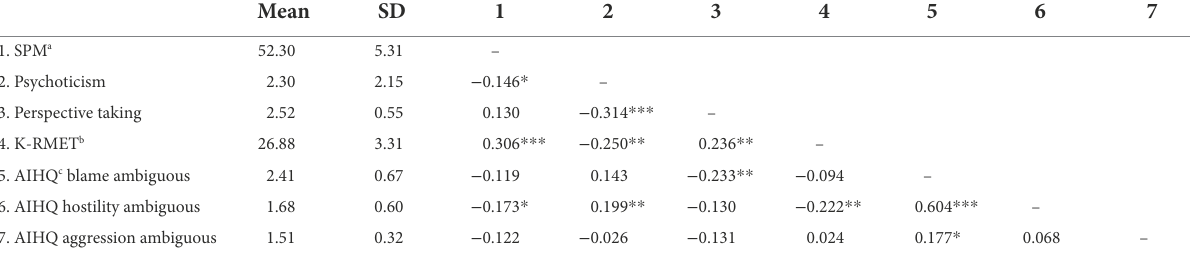
TABLE 1 Descriptive statistics and correlation analysis of variables ( n =